Question: Express in one sentence what the figure is showing.
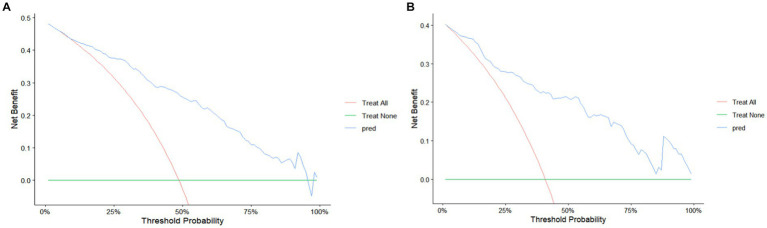
Answer: (A) Decision curve analysis of the training set. (B) Decision curve analysis of the validation set.